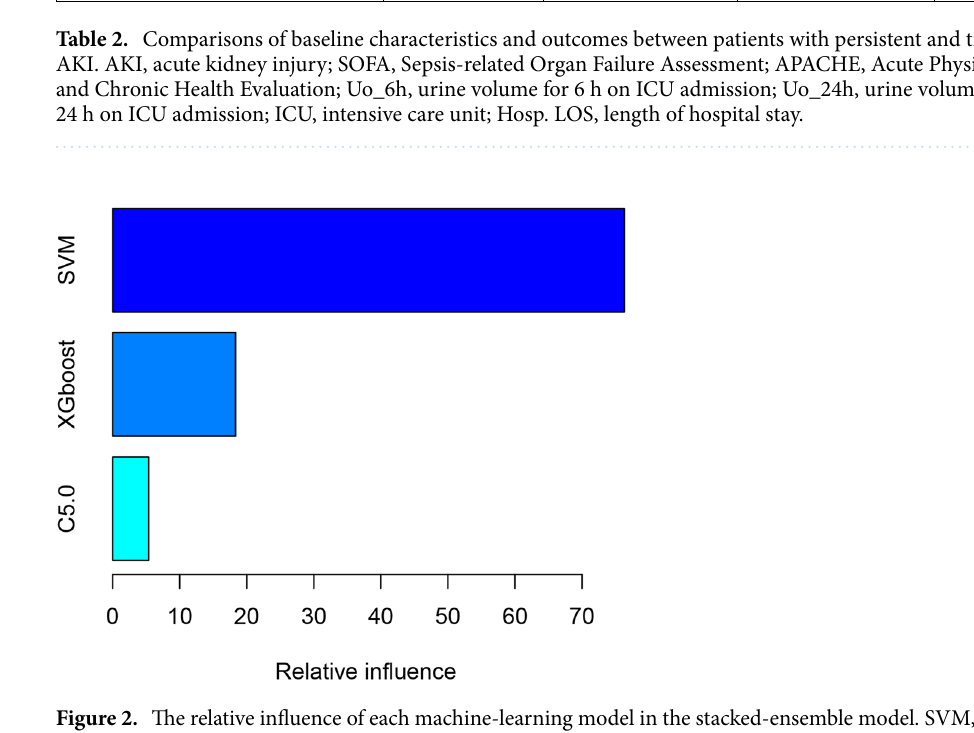
Figure 2. The relative influence of each machine-learning model in the stacked-ensemble model. SVM, support vector machine; XGBoost, extreme gradient